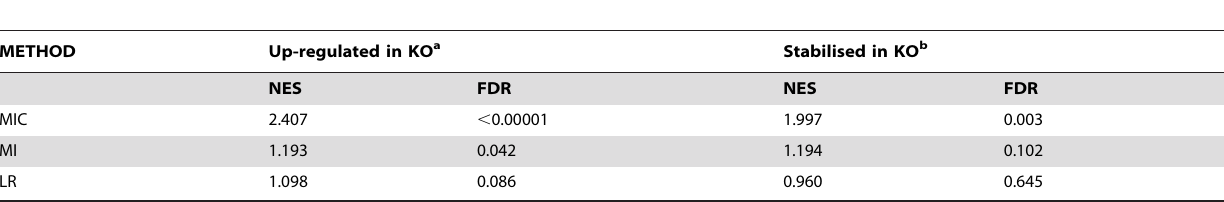
Table 1. Comparison between gene set enrichment validation results for ZFP36-inferred target genes obtained using different metrics of statistical-dependency.